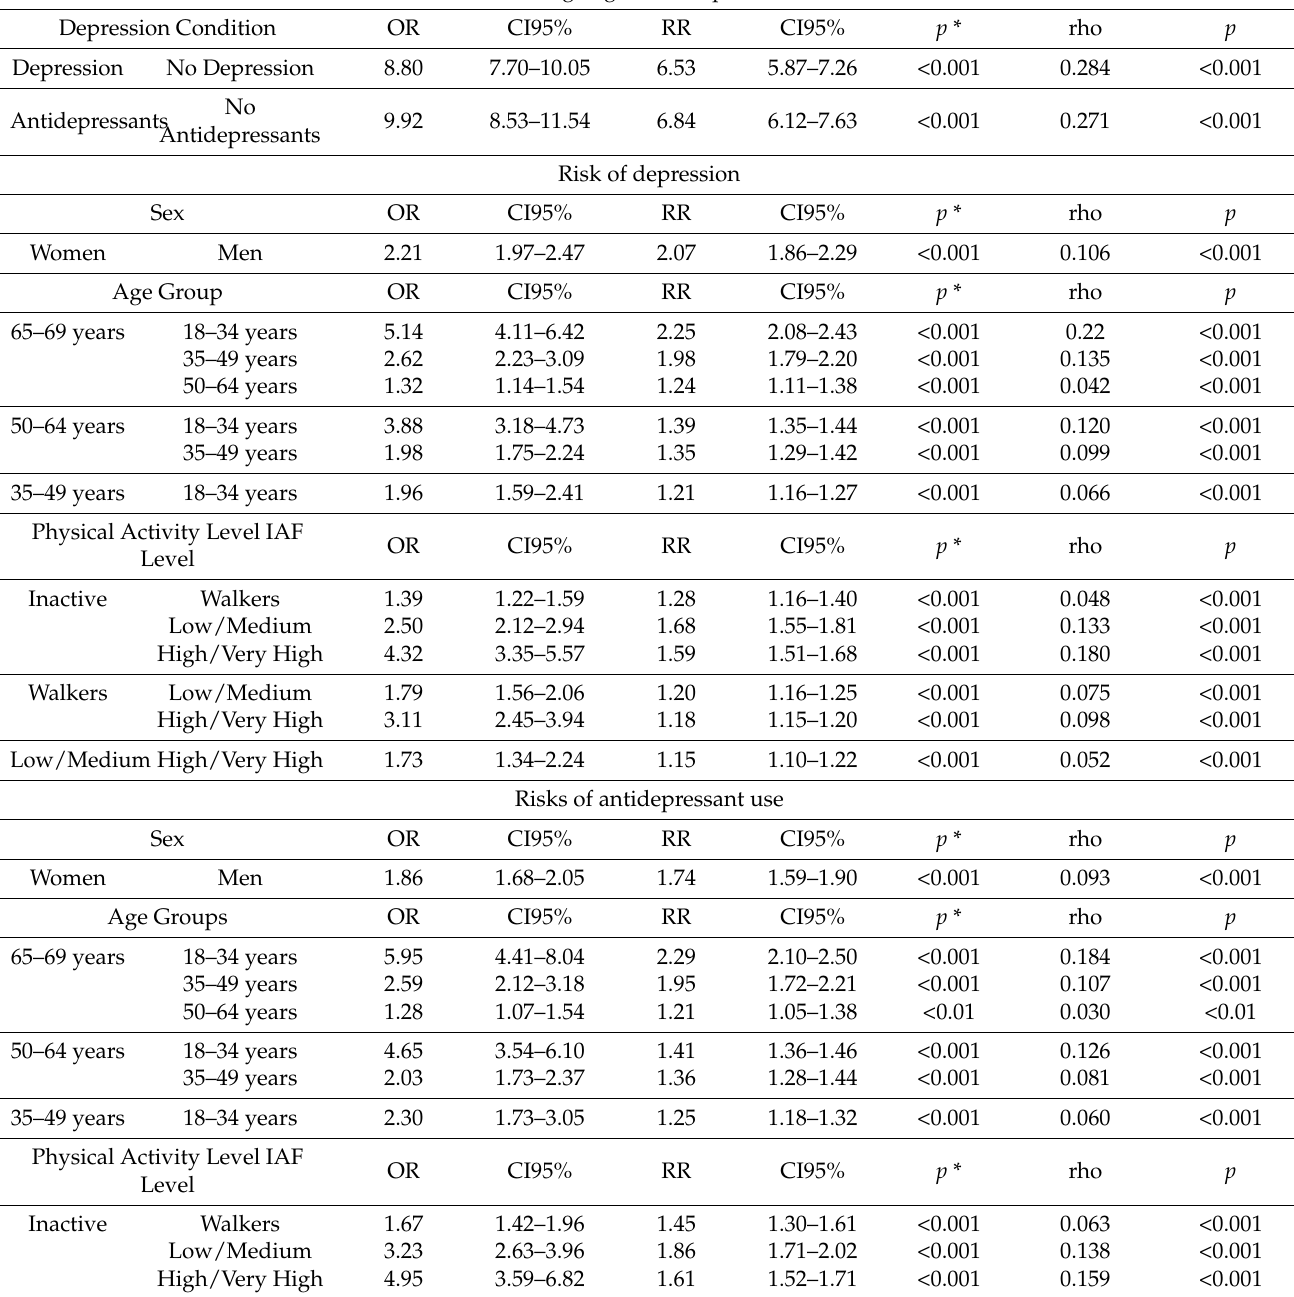
Table 6. In the Spanish population aged 18–69 years: Ratio of probability and relative risk of having a negative perception of health, whether or not suffering from depression, or taking antidepressants; probability and relative risks of suffering from depression and taking antidepressants, according to age group; and level of physical